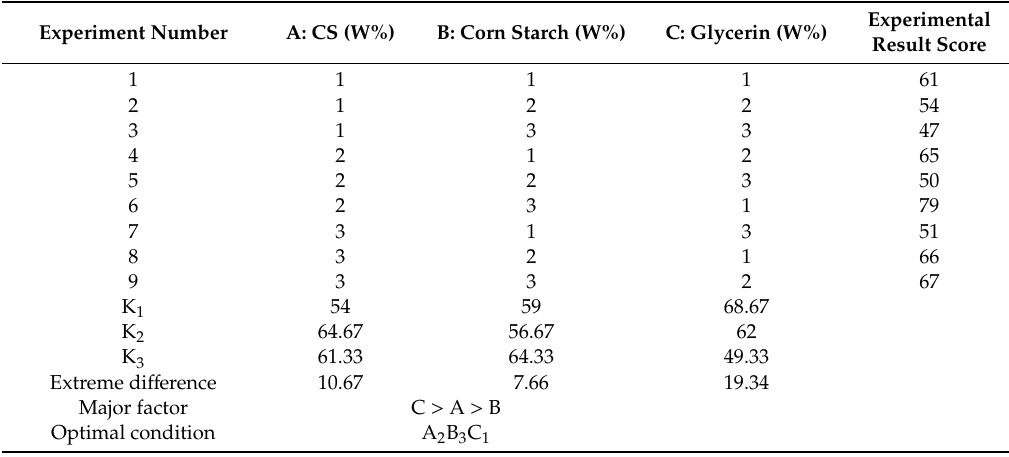
Table 3. Analysis of variance of the physical and chemical properties of the